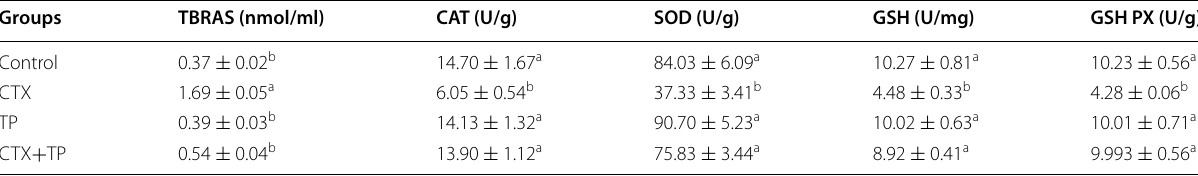
Each value represents mean columbinus (before and after) groups, respectively, p < 0.05 (one-way ANOVA followed by post hoc Tukey)